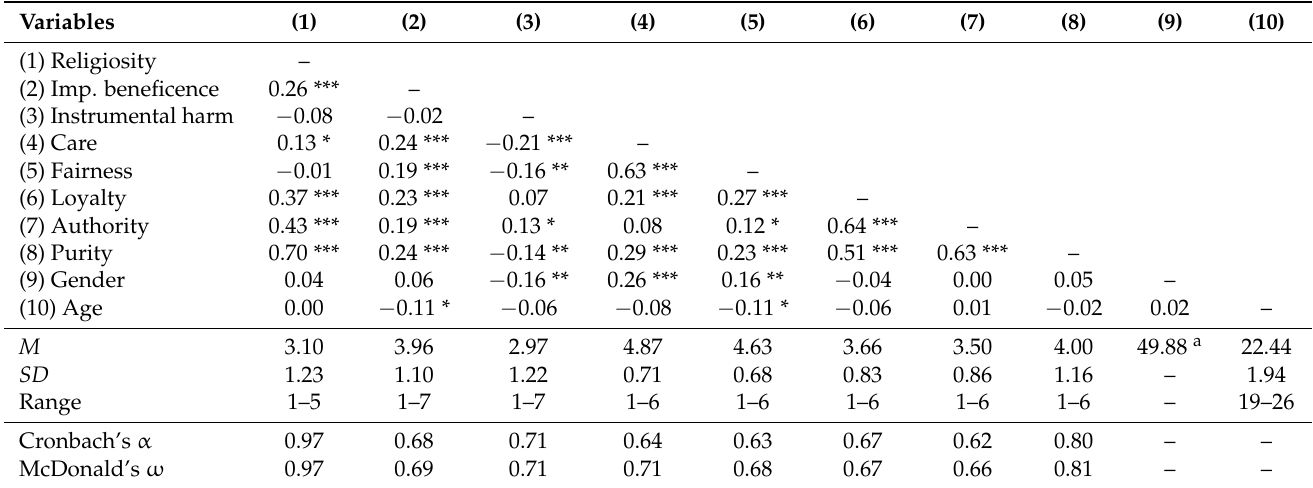
Table 1. Descriptive Statistics, Internal Consistency, and Bivariate Correlations Between